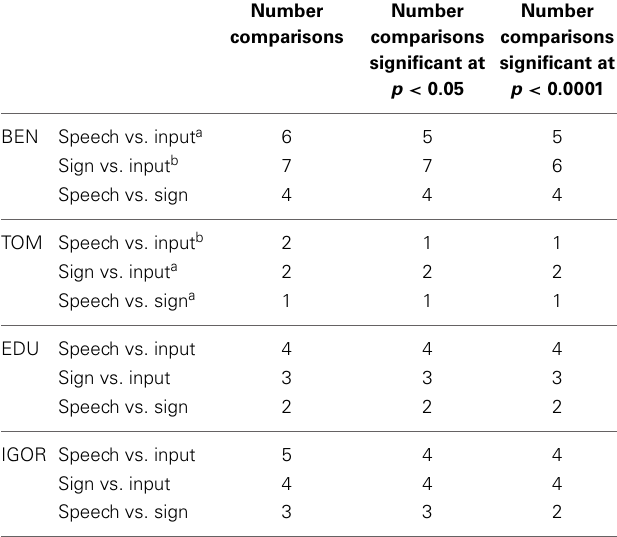
Table 3 | Developmental results.